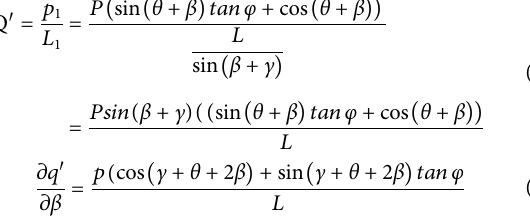
TABLE 5 Cost table of different anchor cable